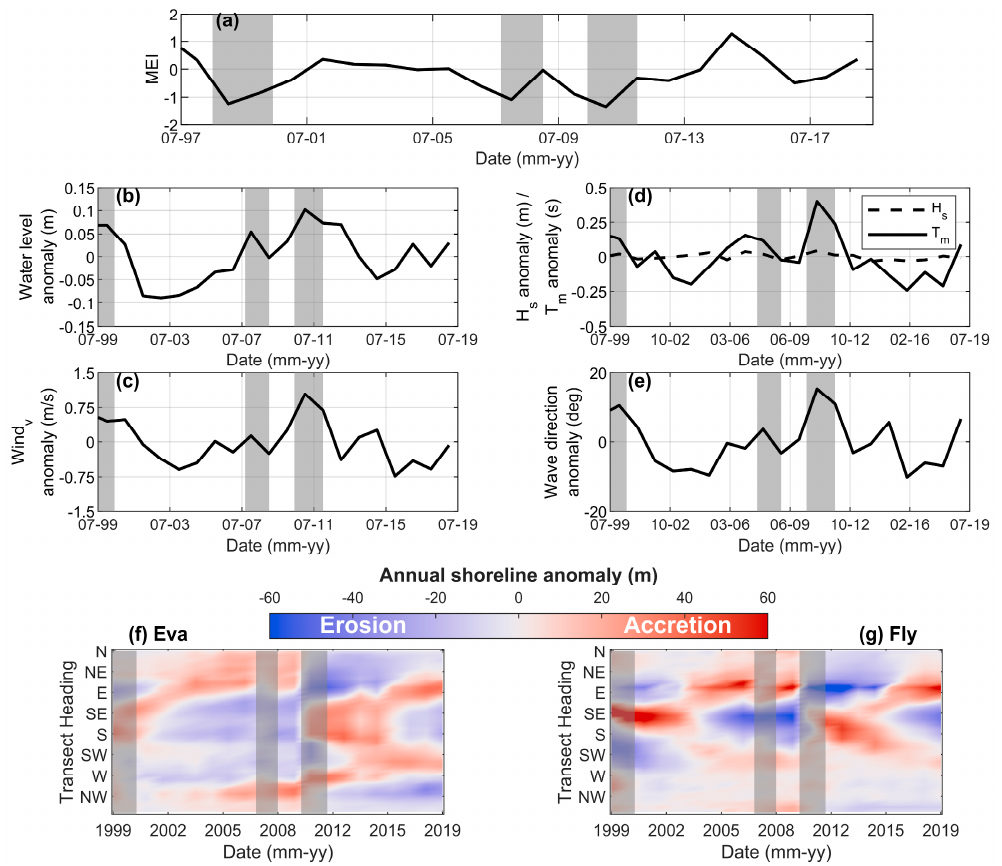
Figure 8. ( a ) Multivariate ENSO Index (MEI), where values less than − 1 denote La Niña. ( b – e ) Interannual anomalies for ( b ) total water level, ( c ) southerly component of wind velocity, ( d ) mean wave period (black line) and significant wave height (dashed black line), and ( e ) mean wave direction. ( f , g ) Interannual shoreline variability at ( f ) Eva and ( g ) Fly, where blue shading denotes erosion, and red shading denotes accretion. In all panels, grey bars denote La Niña